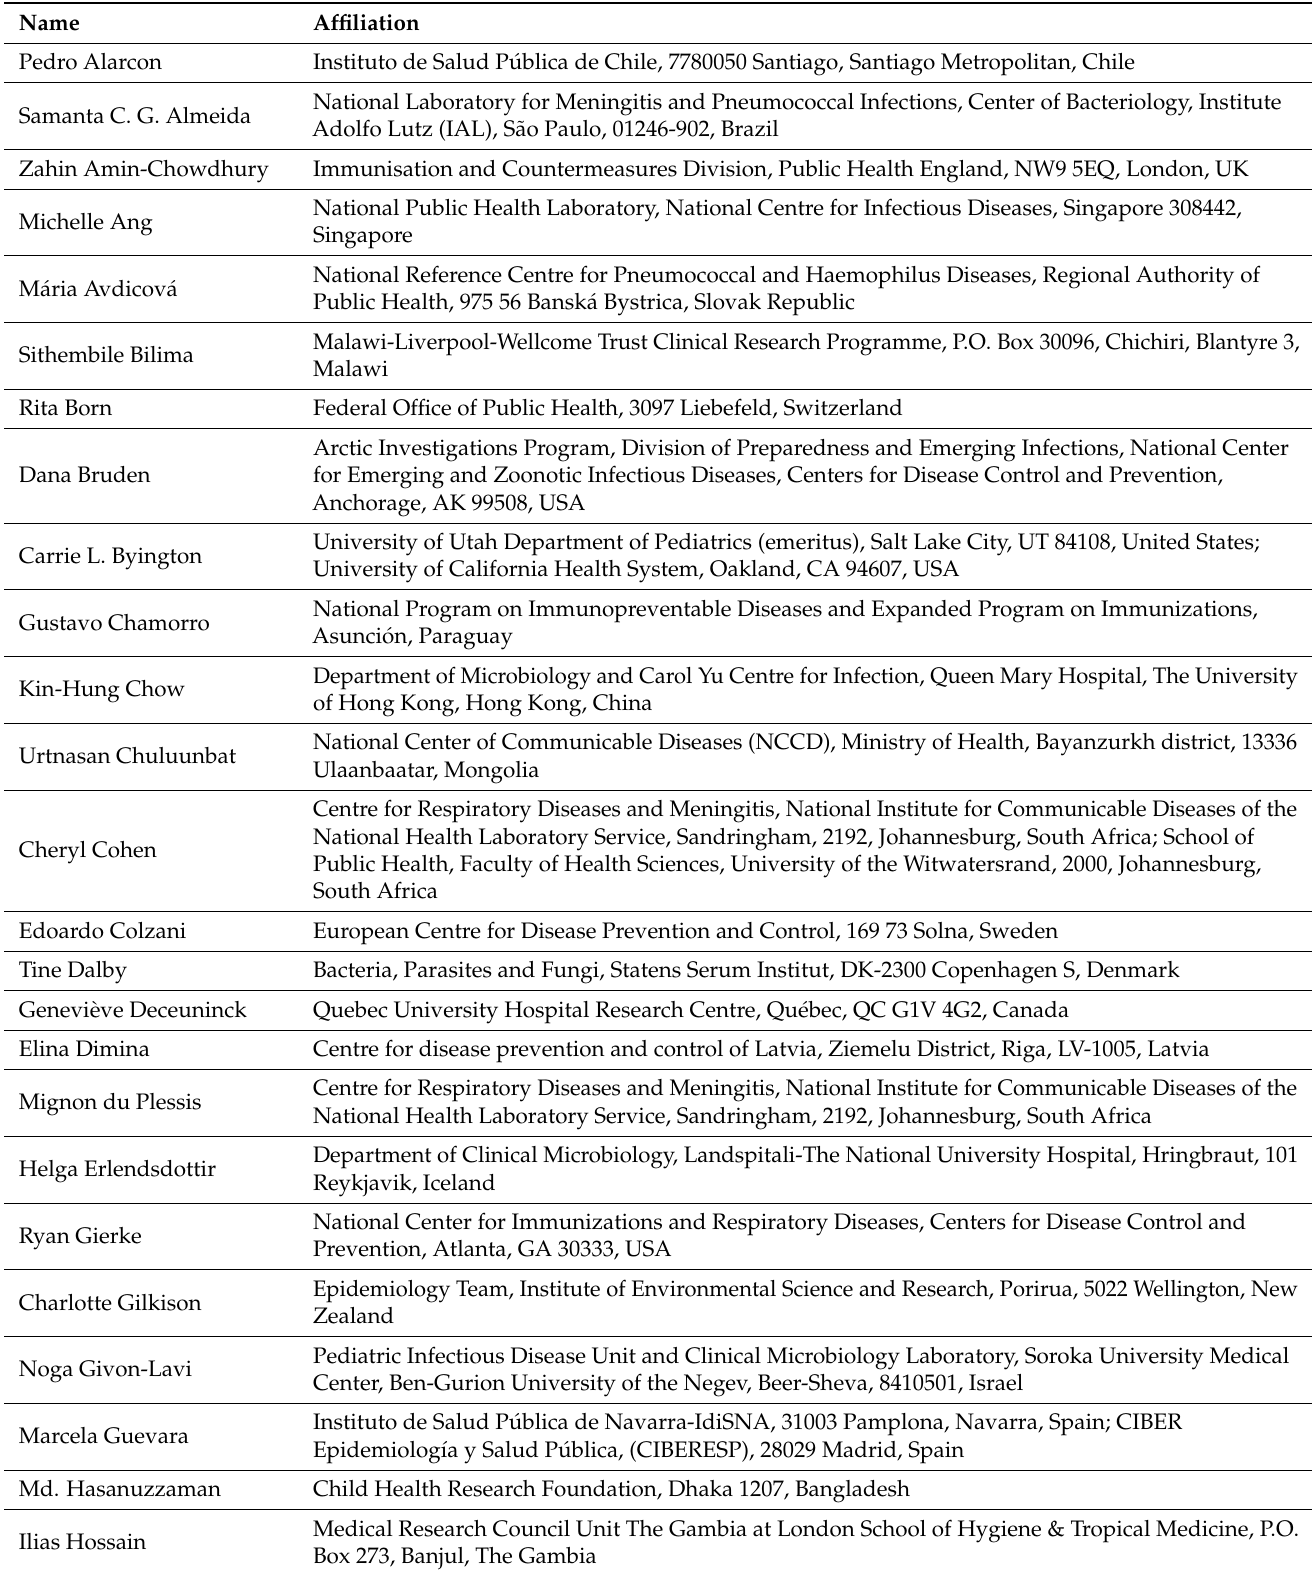
Table A1. PSERENADE